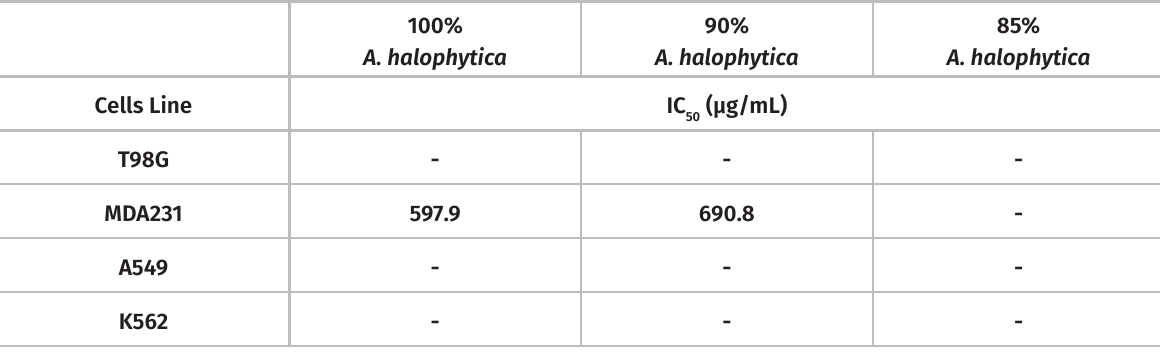
Table I. Inhibitory Concentration from the cyanobacterial